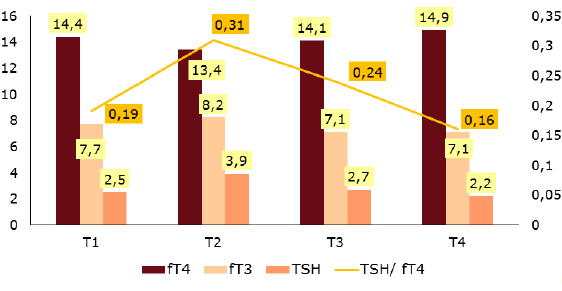
Figure 1. Indicators of the thyroid profile in patients with type 1 diabetes depending on